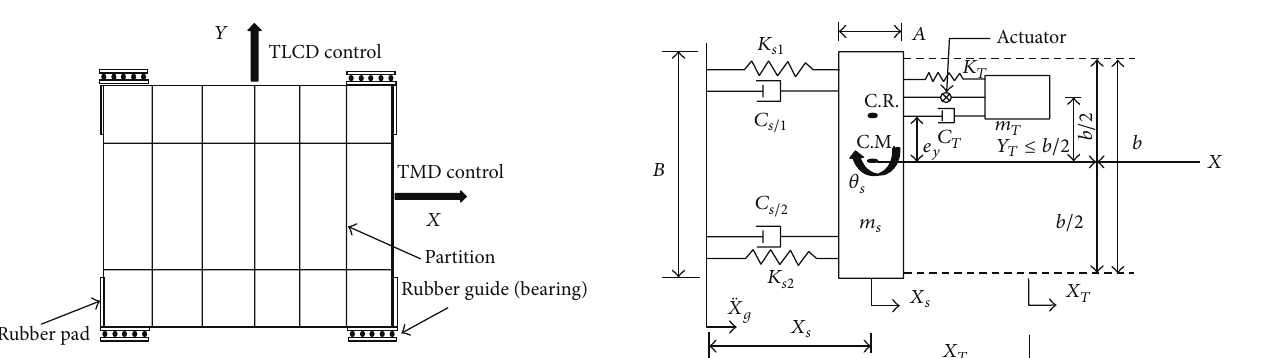
Figure 11. The mathematical expression of the ATMD